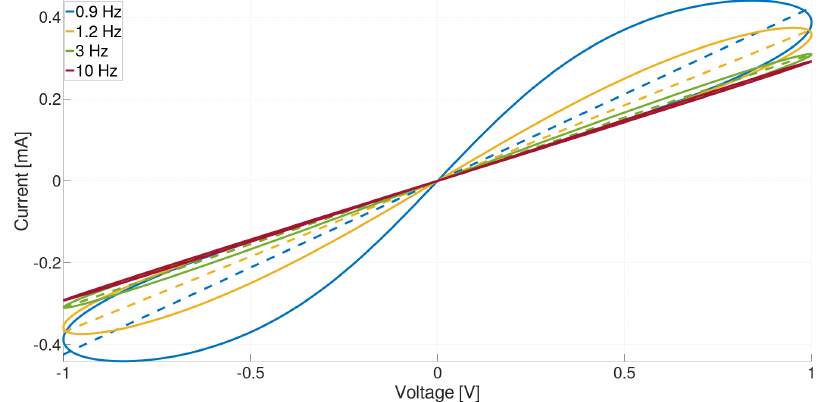
Figure 2. Pinched hysteresis loop of an ideal memristor. The parameters of the model are α = 0, β = 0.3 mA, R on = 1 k Ω and R off = 6 k Ω . The driving voltage is V ( t ) = sin ( 2 π ft ) with f taking several values. We see that, for increasing frequencies, the hysteresis is reduced, eventually converging to a line (resistor). The loop slope (dashed lines) decreases with increasing